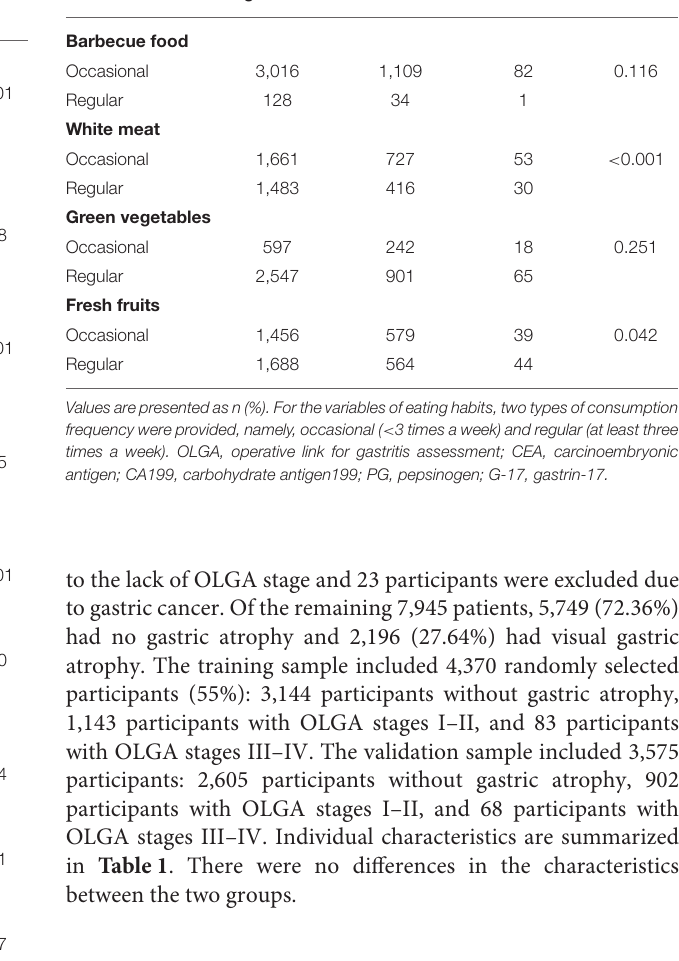
TABLE 2 | Characteristics and diagnostic test results associated with nonatrophic gastritis, OLGA stages I–II and III–IV in the training sample. Nonatrophic